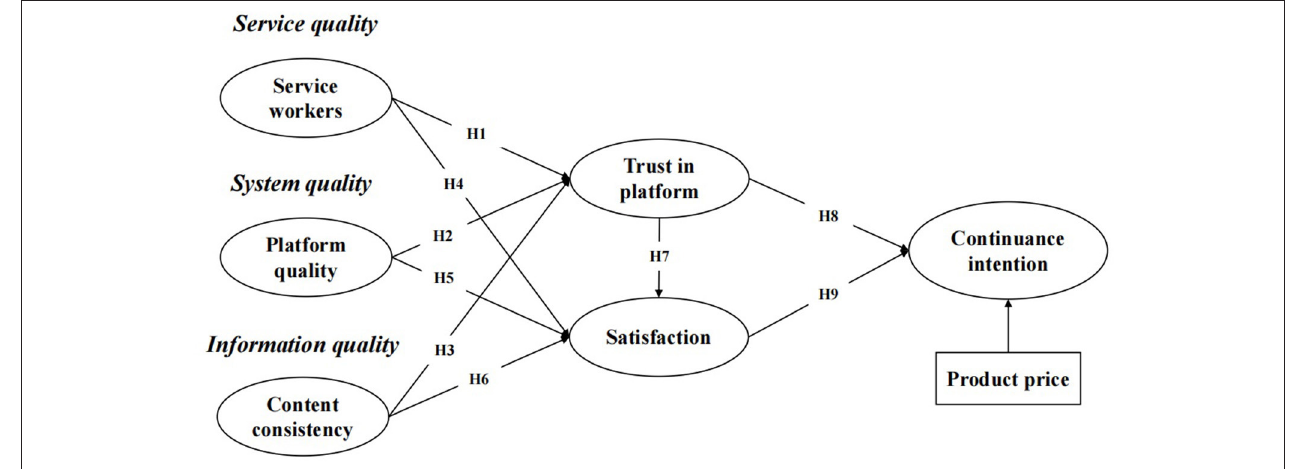
FIGURE 1 | Research